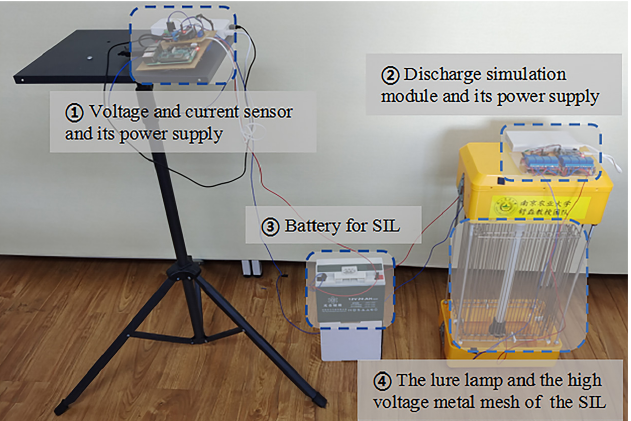
Figure 2. The experiment devices which are used to calculate energy